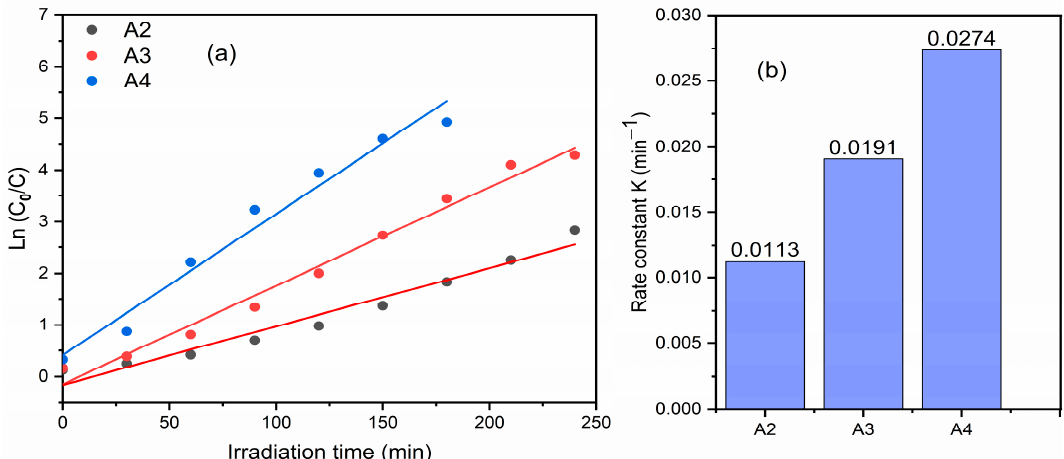
Figure 6. ( a ) Pseudo-first-order kinetics and ( b ) the rate constant k of the photocatalysts. The high rate constant observed for the A4 sample can be principally due to